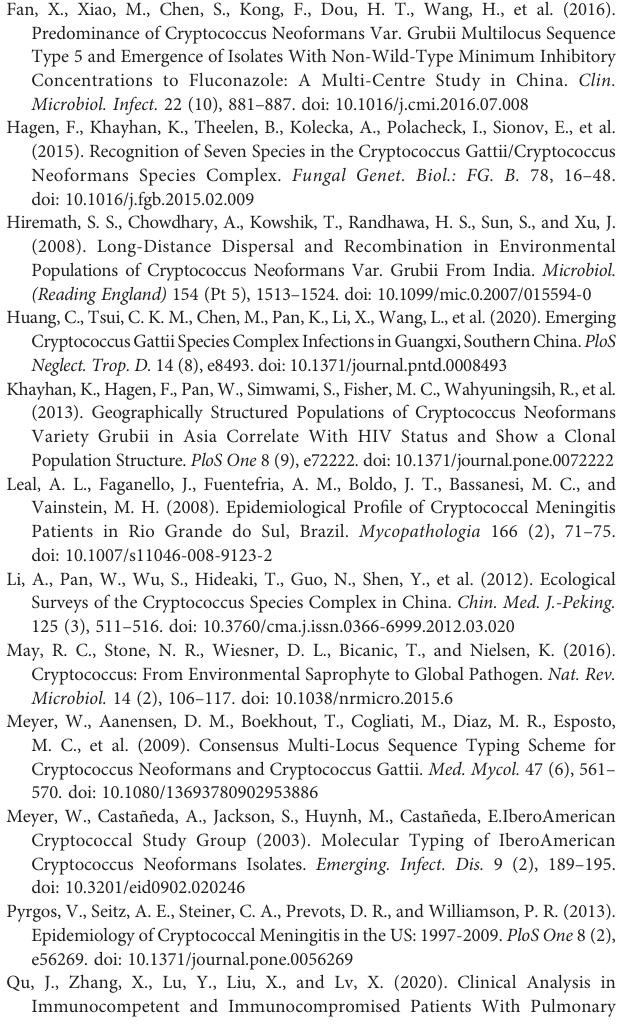
Supplementary Table 4 | The list of gene bank accession numbers for seven genes of 199